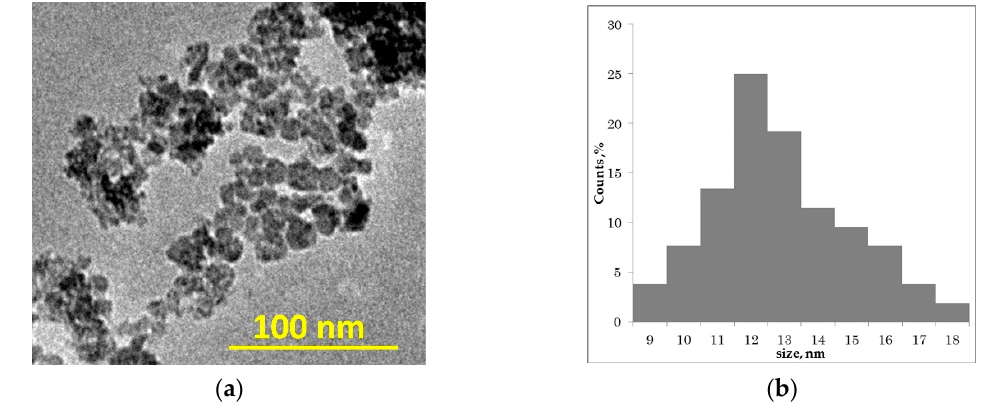
Figure 9. ( a ) TEM image of fretting wear products (dry friction, p = 15 MPa); ( b ) size distribution of nanoparticles.